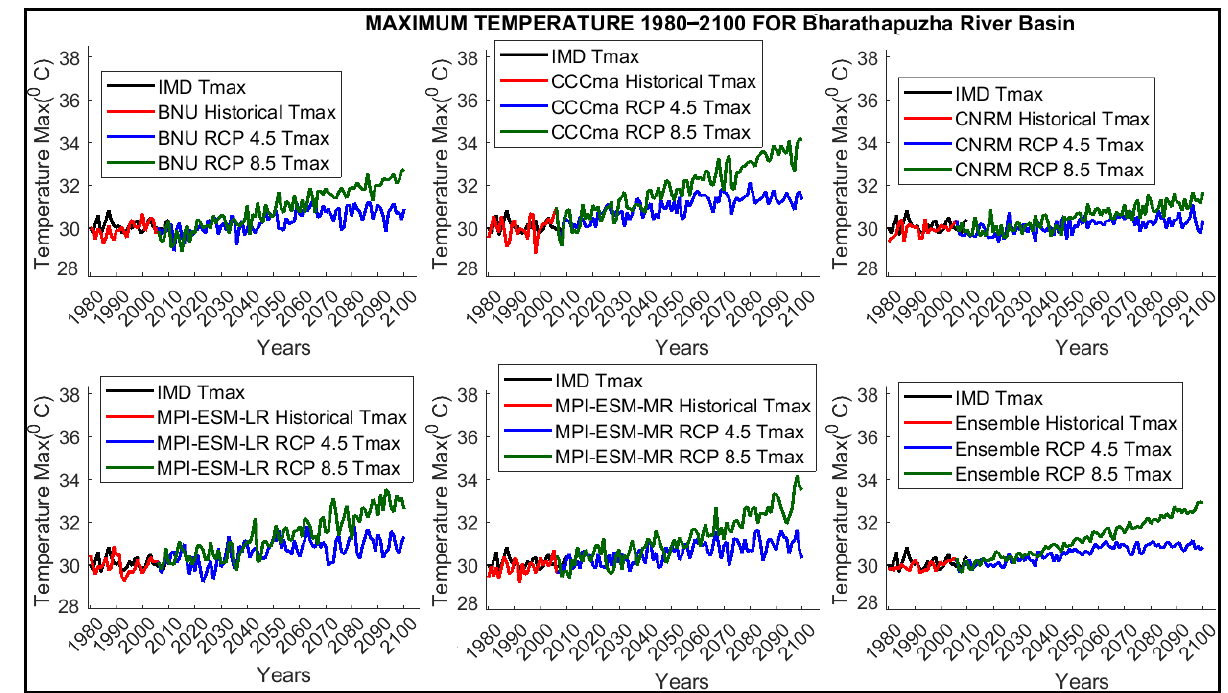
Figure 6. Comparison of observed and GCMs simulated maximum temperature during historical (1981 to 2010) and future periods (2011 to 2100).